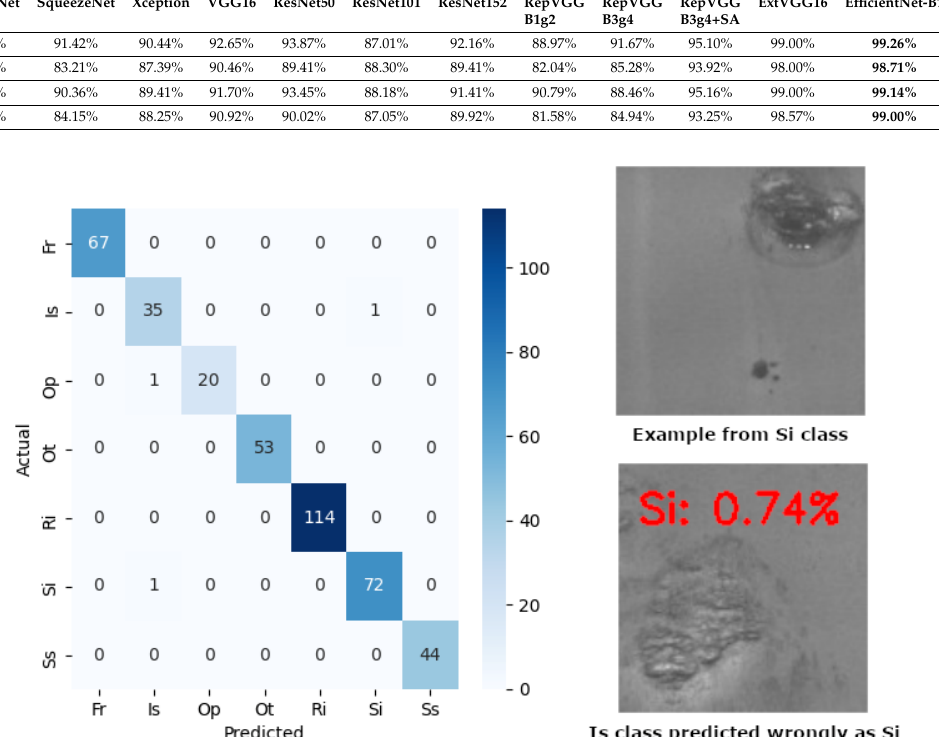
Figure 4. ( Left ) Confusion matrix of EfficientNet-B7 classification of the seven error types of the X-SSD dataset. ( Right ) An example image of the Si class and an Is defect wrongly classified as